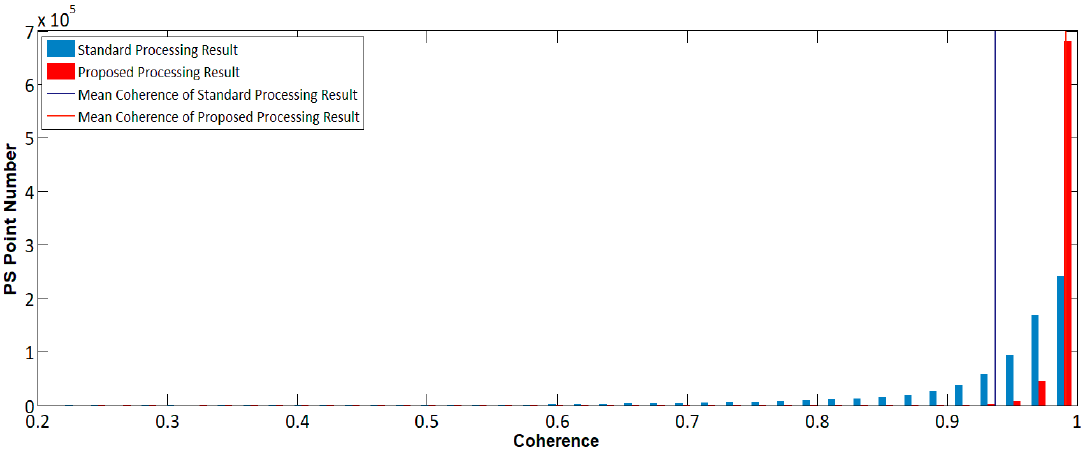
Figure 15. Histogram of PS points for temporal coherence in both standard and proposed processing